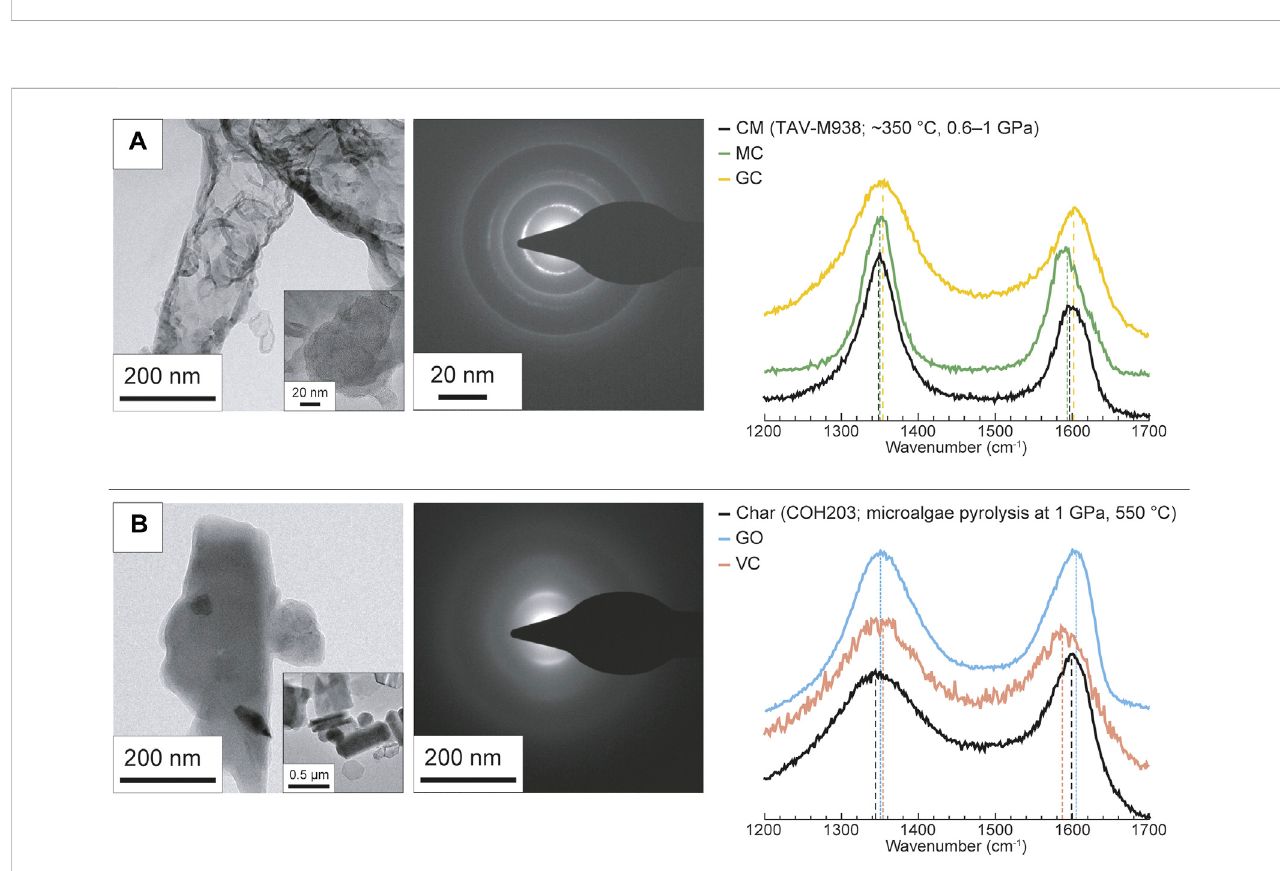
FIGURE 7 Representative TEM images, SAED diffraction patterns and Raman spectra of (A) disordered char obtained from pyrolysis of green microalgae at 550 ° C and1 GPa(experimentCOH203)and (B) CMextractedfromsampleTAV-M938(300 ° C – 400 ° C,.6 – 1 GPa;VitaleBrovaroneetal.,2013).Theinsetsshow:in (A) thelocalpresenceofhexagonal graphite crystals; in (B) aportion ofCM where microporous to “ onion-ringlike ” texturesdominate.Ramanspectra ofGC,GO and MC are reported for comparison.